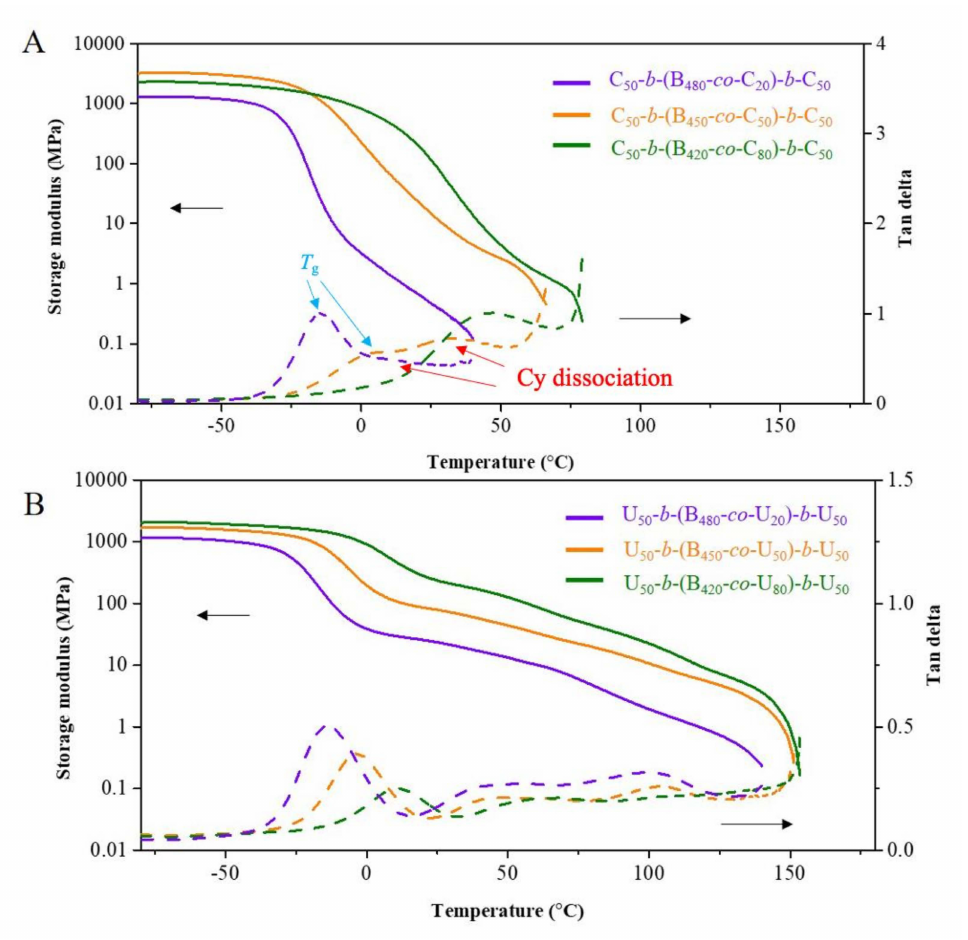
Figure 4. Dynamic mechanical temperature ramps of storage modulus and tan δ of the solution casted ( A ) CyA and ( B ) UCyA triblock copolymer